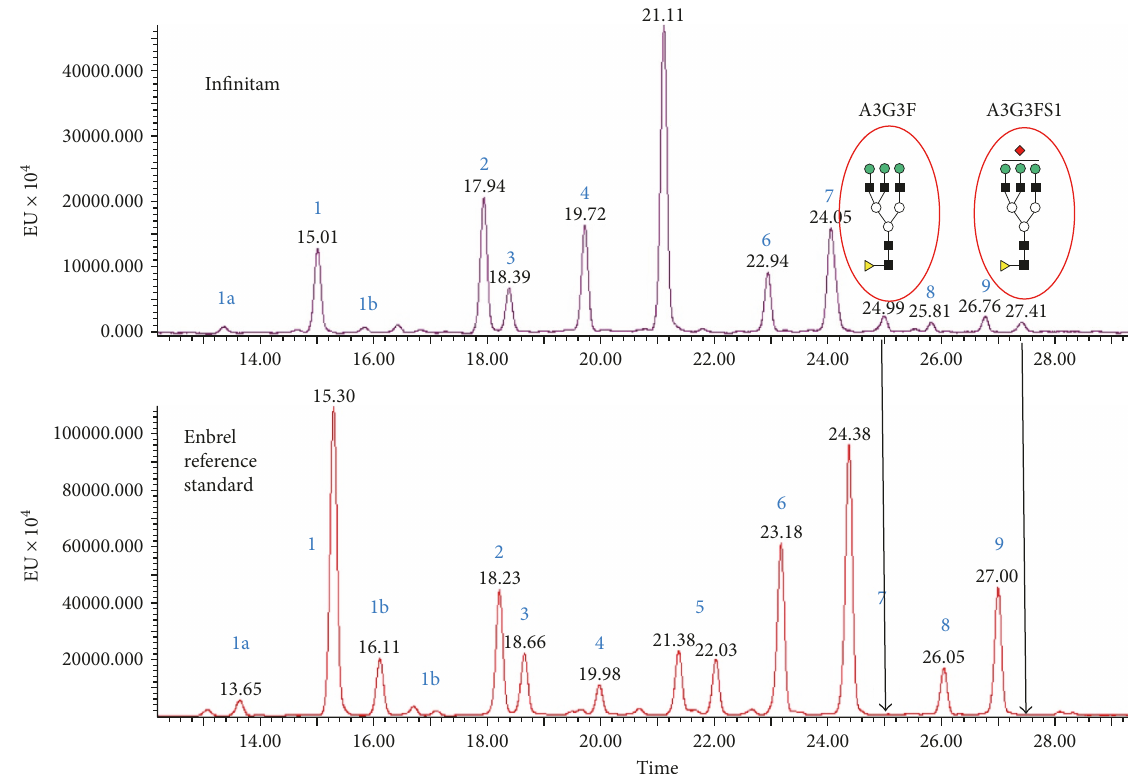
Figure 2: P fi zer ’ s analysis of one representative batch of In fi nitam by UPLC versus Enbrel reference standard. Note: All major glycans observed in Enbrel were identi fi ed in each of the three batches of In fi nitam drug product. The overall abundance of grouped neutral (peaks 1 – 5) and sialylated (peaks 6 – 9) species was outside the commercial experience of Enbrel. In fi nitam would not be regarded as comparable to Enbrel due to the presence of two glycan species in each batch of In fi nitam which are not resolved in Enbrel (arrows show baseline for